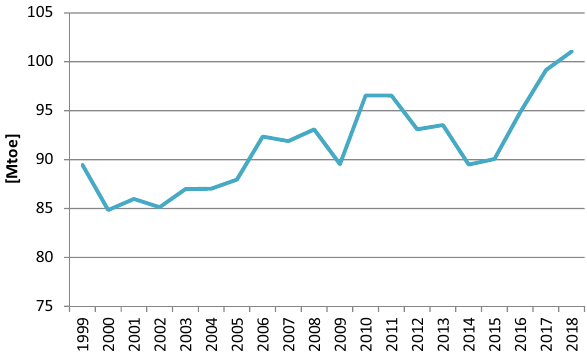
Figure 8: Primary energy consumption in Poland in the years 1999 – 2018. Source: own work based on ref. [ 5